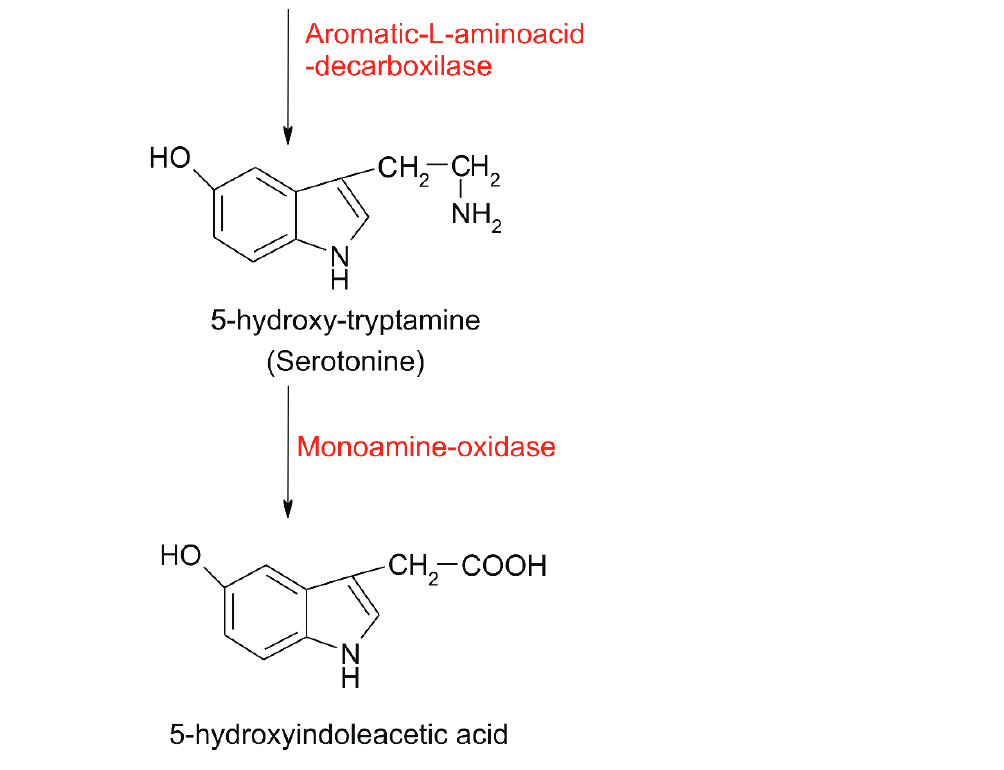
Figure 1. Serotonin synthesis and degradation to 5-hydroxyindolaceticacid (adapted from [20]).